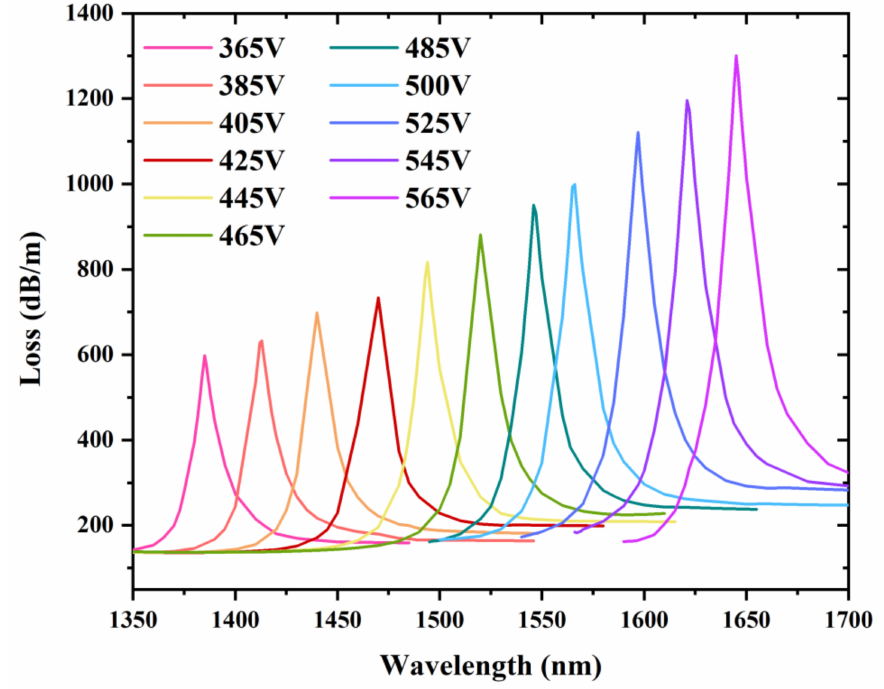
Figure 4. The shift of the loss spectrum of the fiber mode in the x-polarized direction as the voltage increases from 365 to 565 V.